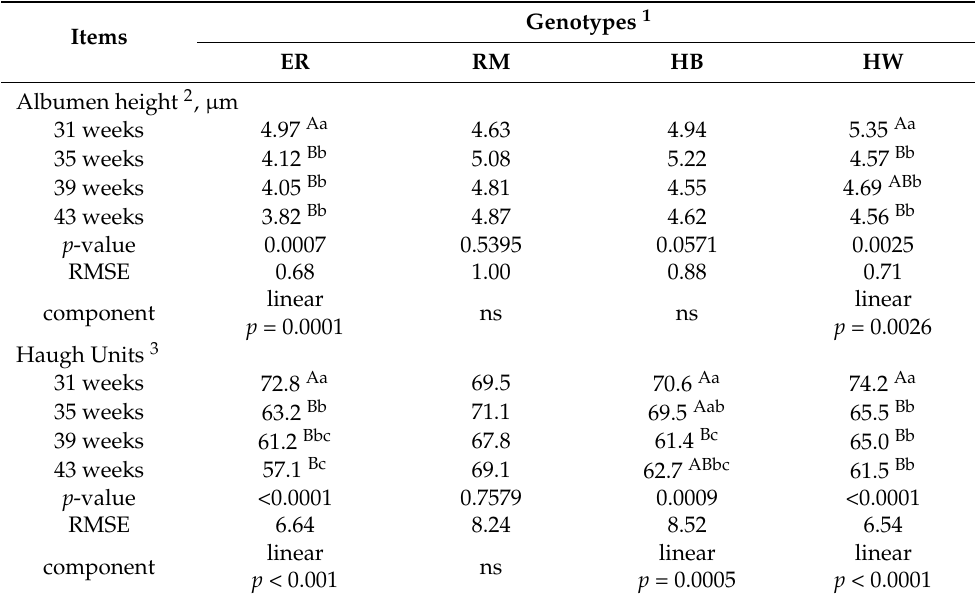
Table 5. Effect of age on albumen height and Haugh Units of stored 14 d eggs according to the genotype of the